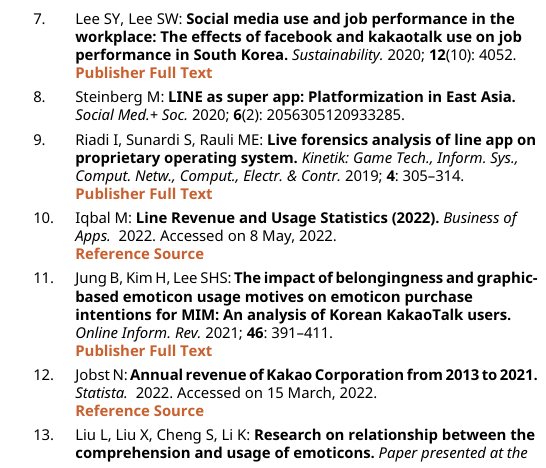
(cid:129) Survey form.pdf. (Paid sticker questionnaire used in this